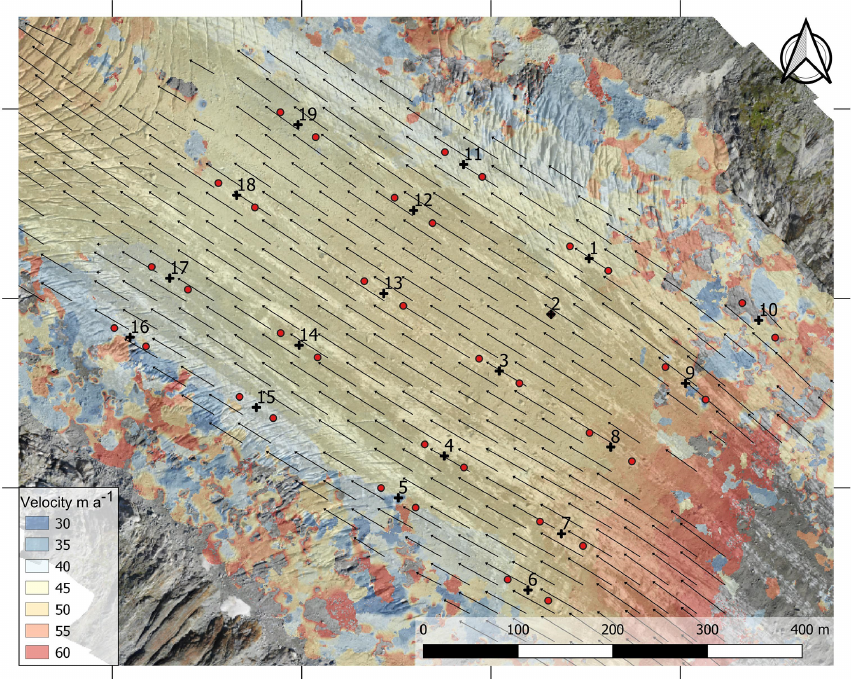
Figure 9. Horizontal velocities obtained from feature tracking (Cosi-Corr) using UAV images. The black crosses show the locations where the vertical velocities were observed. The red dots correspond to the ends of horizontal vectors for 2018/2019, determined from UAV images.